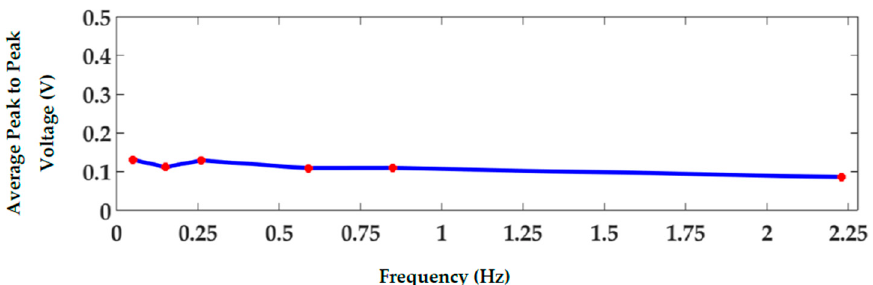
Figure 9. Average peak-to-peak voltage plotted versus frequency at which the ERB is expanded/contracted. The points which were actually measured are marked as red.